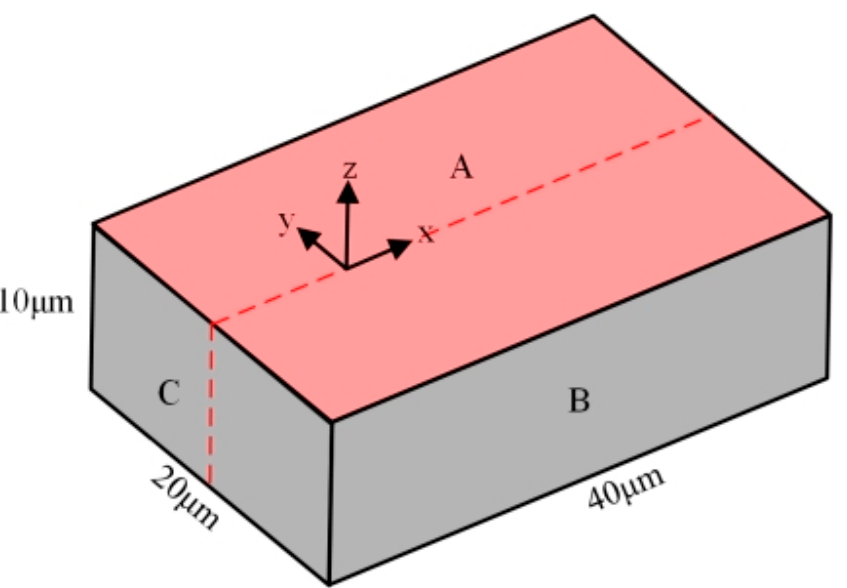
Figure 3. Micro-element on the micro-bit surface.